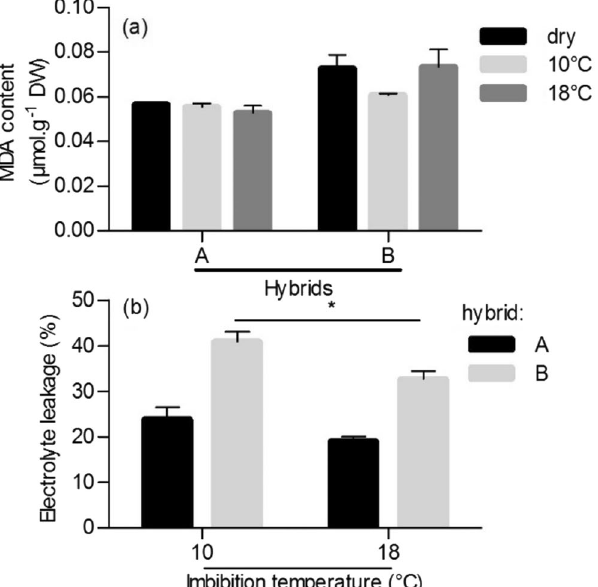
Figure 2. Malondialdehyde (MDA) embryo content ( a ) and electrolyte leakage ( b ) of seeds of hybrids A and B after 24 h imbibition at 10 °C and 18 °C. Means of 3 replicates. Vertical bars correspond to SD. Asterisks above the bar indicate that electrolyte leakage in hybrid B at 10 °C differed significantly from that measured at 18 °C ( * P <